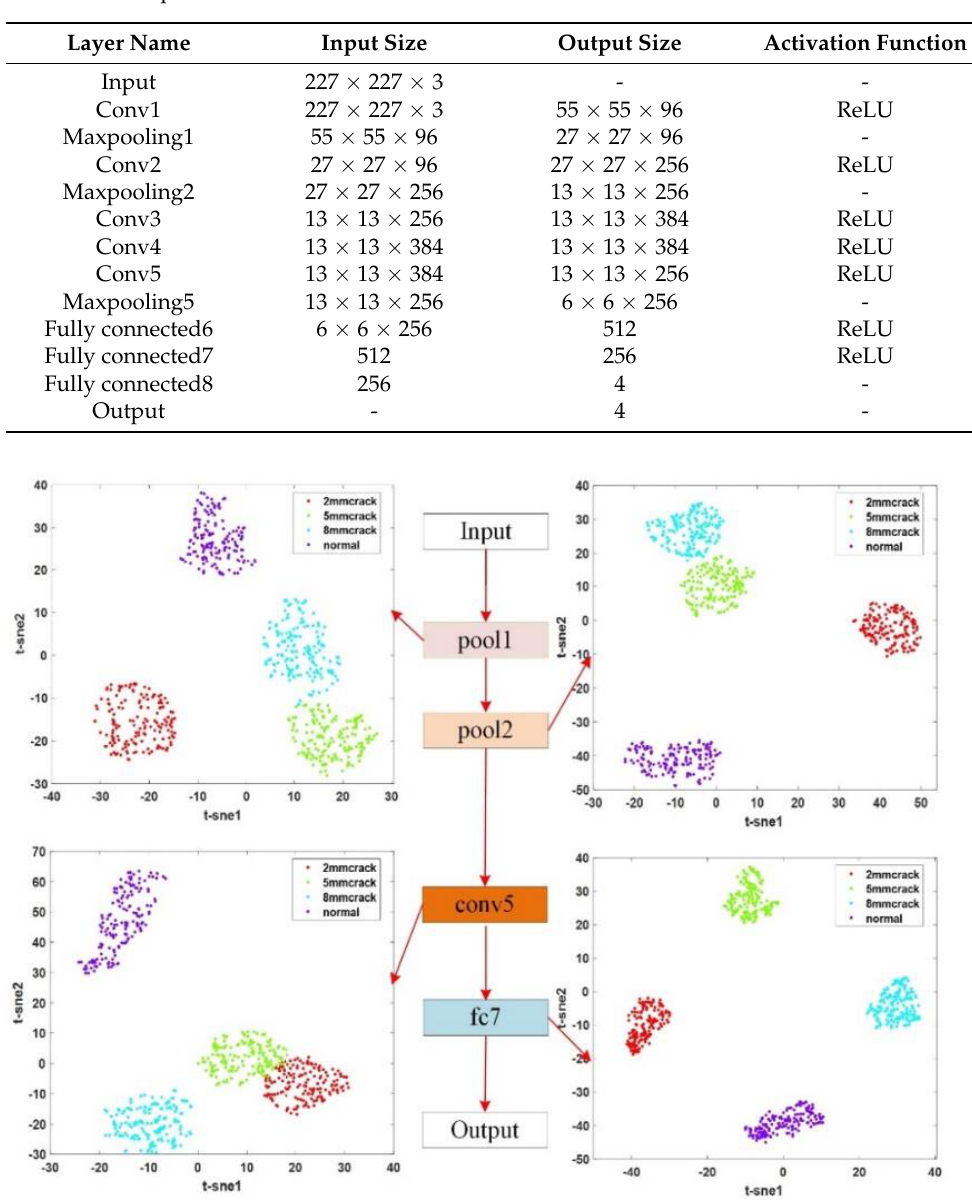
Figure 13. Scatter plot of image features on different layers for four different working conditions.